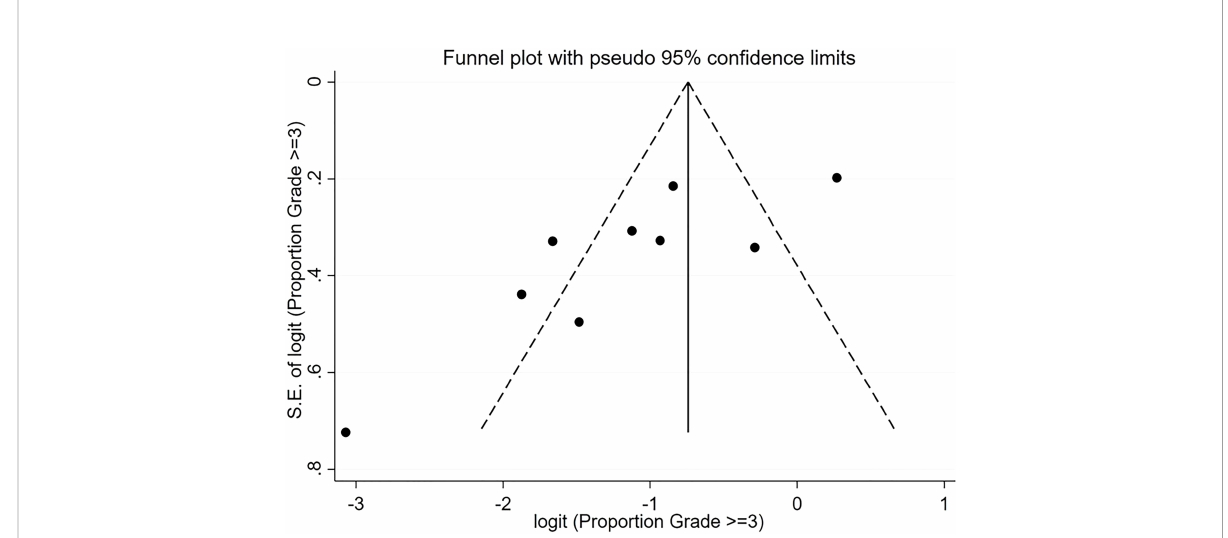
FIGURE 7 Funnel plot with pseudo 95% con fi dence limits for the estimation of the publication bias for the Grade ≥ 3 proportion with the logit